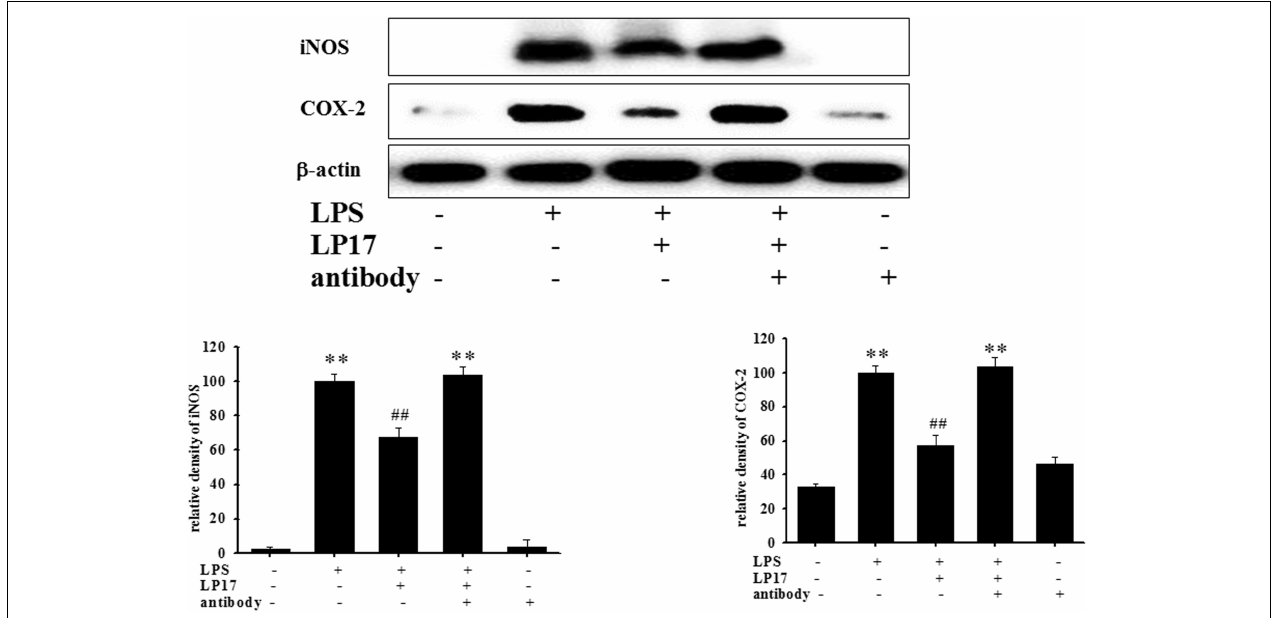
FIGURE 5 | The treatment of TREM-1 agonist antibody reduced the anti-inflammatory effects of LP17 on iNOS and COX-2 expressions in LPS-stimulated murine BV-2 microglial cell line ( n = 4/group). Western blotting for iNOS and COX-2 expression of control, LPS, LPS plus LP17, LPS plus LP17 + agonist antibody, and agonist antibody group after the BV-2 microglial cells were treated with 10 µ g/ml LP17 plus 100 ng/ml LPS for 6 h and 30 min, followed by the addition of 5 µ g/ml TREM-1 agonist antibody to the solution for 16 h. The agonist antibody significantly inhibited the anti-inflammatory effect of LP17 on LPS-induced upregulation of iNOS and COX-2 expressions. The bars represent the mean ± SEM. The data were analyzed using two-way ANOVA. ∗∗ P < 0.05 versus the control group; ## P < 0.05 versus the LPS group.